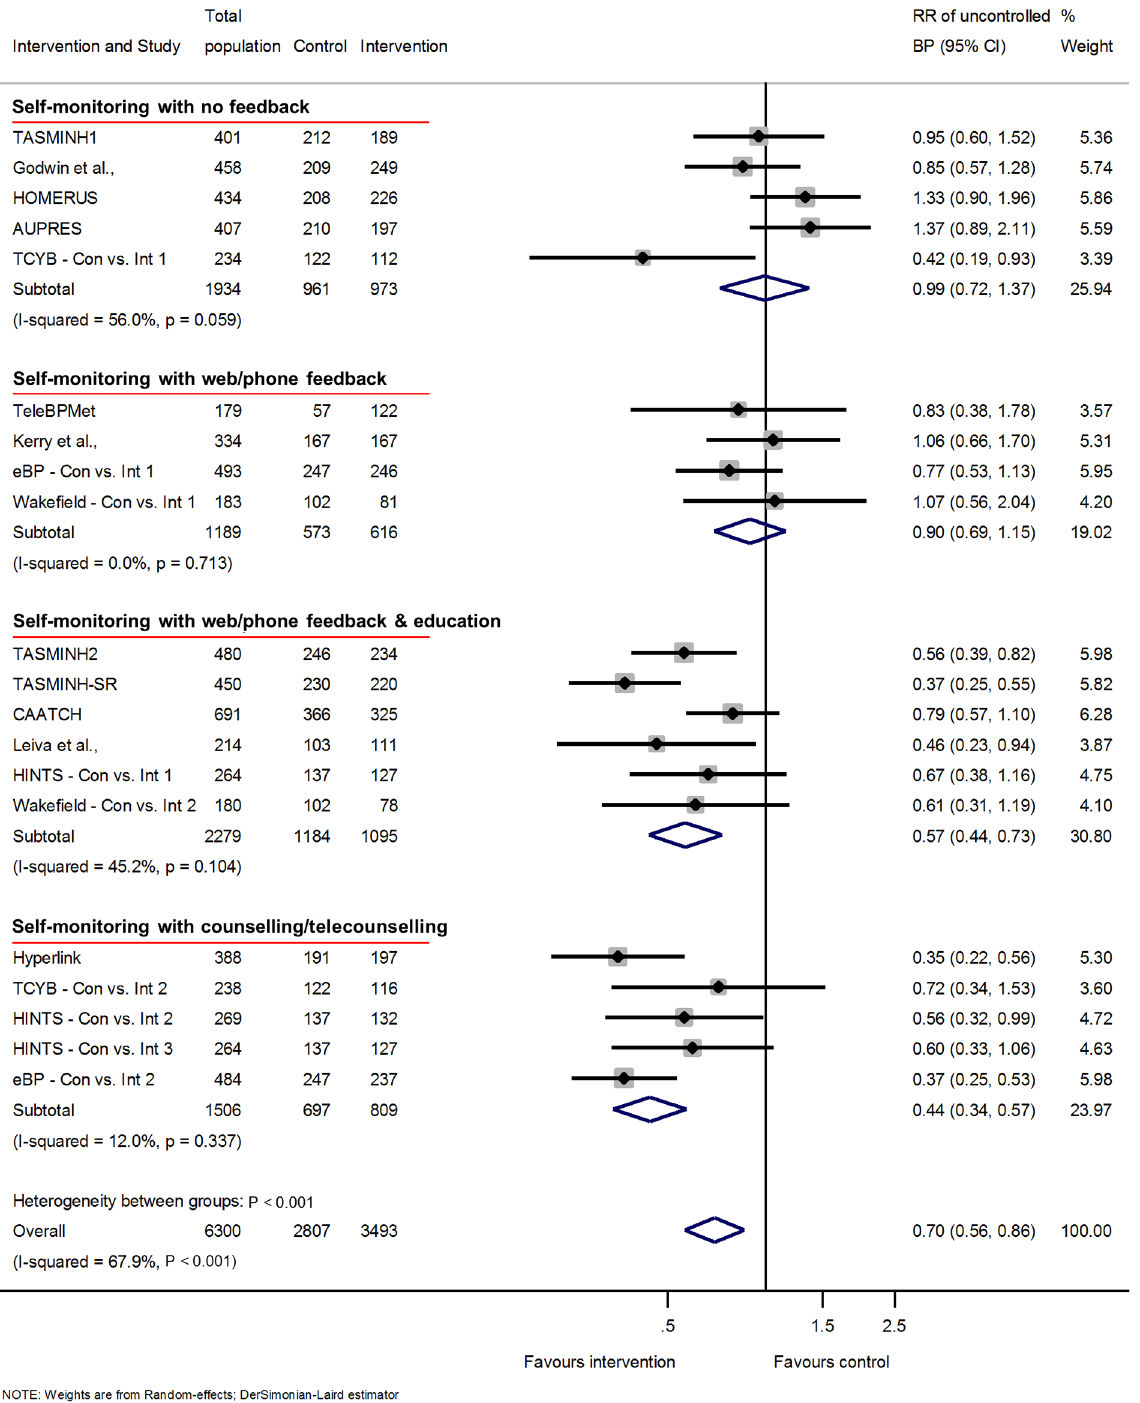
Fig 3. Impact of self-monitoring of BP on the RR of uncontrolled BP at 12 months according to level of co-intervention support (15 studies). RR of uncontrolled BP adjusted for age, sex, baselineclinic BP, and history of diabetes. The trials are grouped into the 4 levels of intervention, and I 2 and P values are shown for each level of intervention and for the overall analysis. The effect of self-monitoring on the RR of BP at 6 and 18 months are displayedin S5 and S8 Figs, respectively. Wakefieldstudy participantsself- monitored for 6 months; follow-upcontinuedto 12 months. Abbreviations: BP, blood pressure; RR, relative risk.